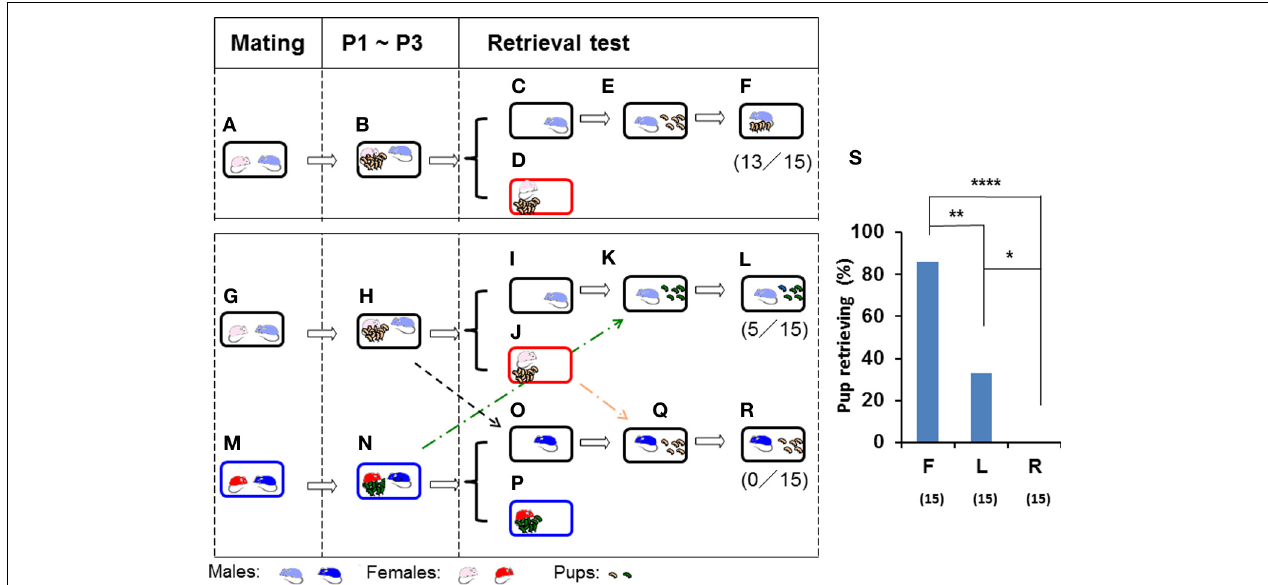
FIGURE 1 | Parental retrieval test in ICR mice for biological and non-biological pups. Schematic representations of the parental care test in three mated pairs (A,G,M) . After cohabiting with their pups as a family for 3 days from postnatal day 1 (P1) until postnatal day 3 (P3) (B,H,N) , the sires were separated in the home cage (C,I,O) from the pups and pairmates (D,J,P) for 10min. The sires were then reunited with five biological (E) or non-biological (K) pups. Subsequent pup retrieval behavior over a 10-min period was then observed (F,L) . The third sire (M,N) was placed in the home cage (O) of